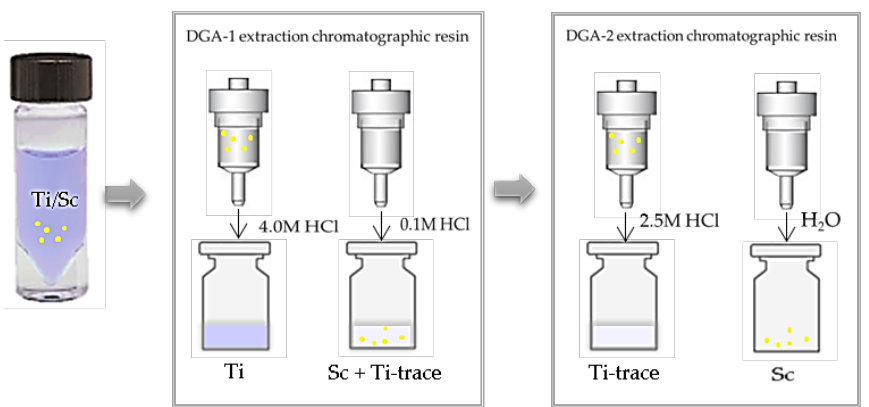
Figure 4. Schematic representation of the separation of scandium is from titanium using DGA-extraction chromatographic resin.